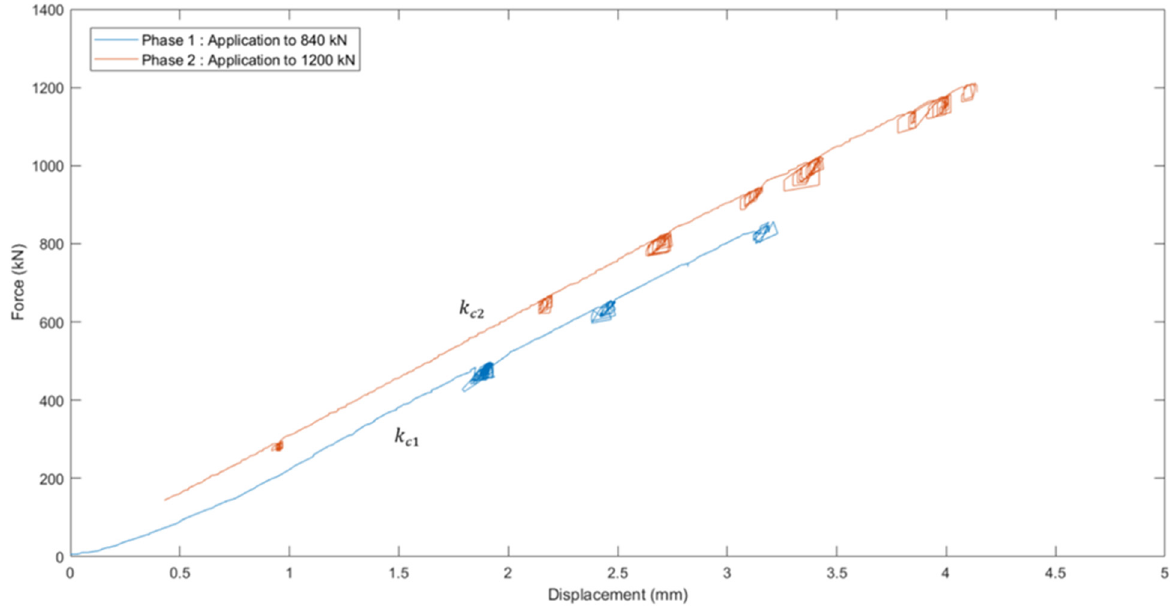
Figure 8. Compression loading, all phases of force application (no